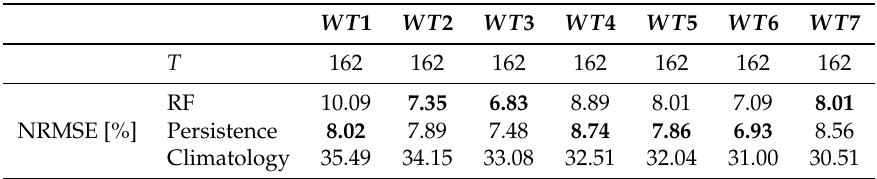
Table 5. Normalised root-mean-square-error (NRMSE), in % of the nominal capacity ( P n ), of five-minute ahead forecasts for the seven turbines of the first row, for the case of a reduced radar availability (Figure 12b). Results are shown for the remote sensing-based forecasting (RF) model, persistence and climatology benchmarks.